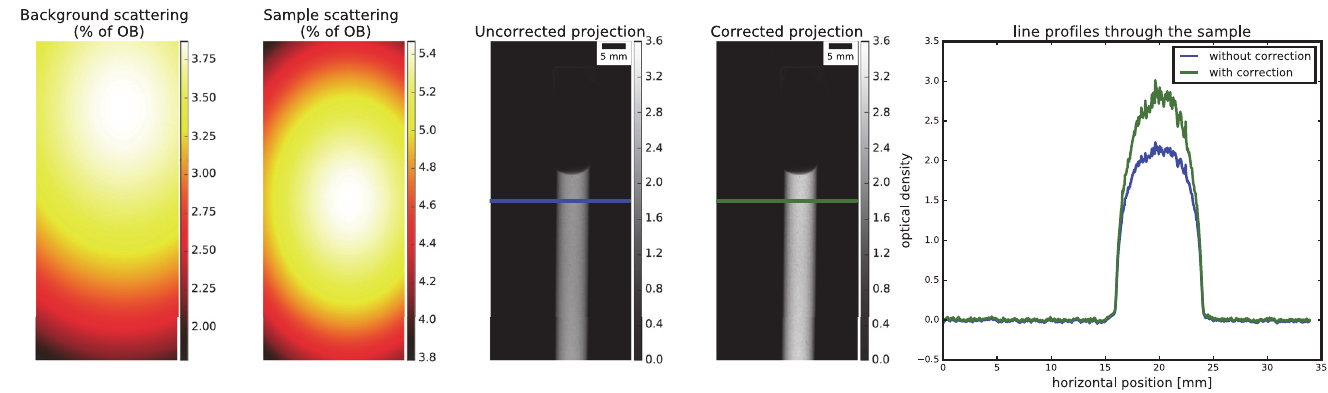
Fig 2. Computed background and correction on radiography for the water